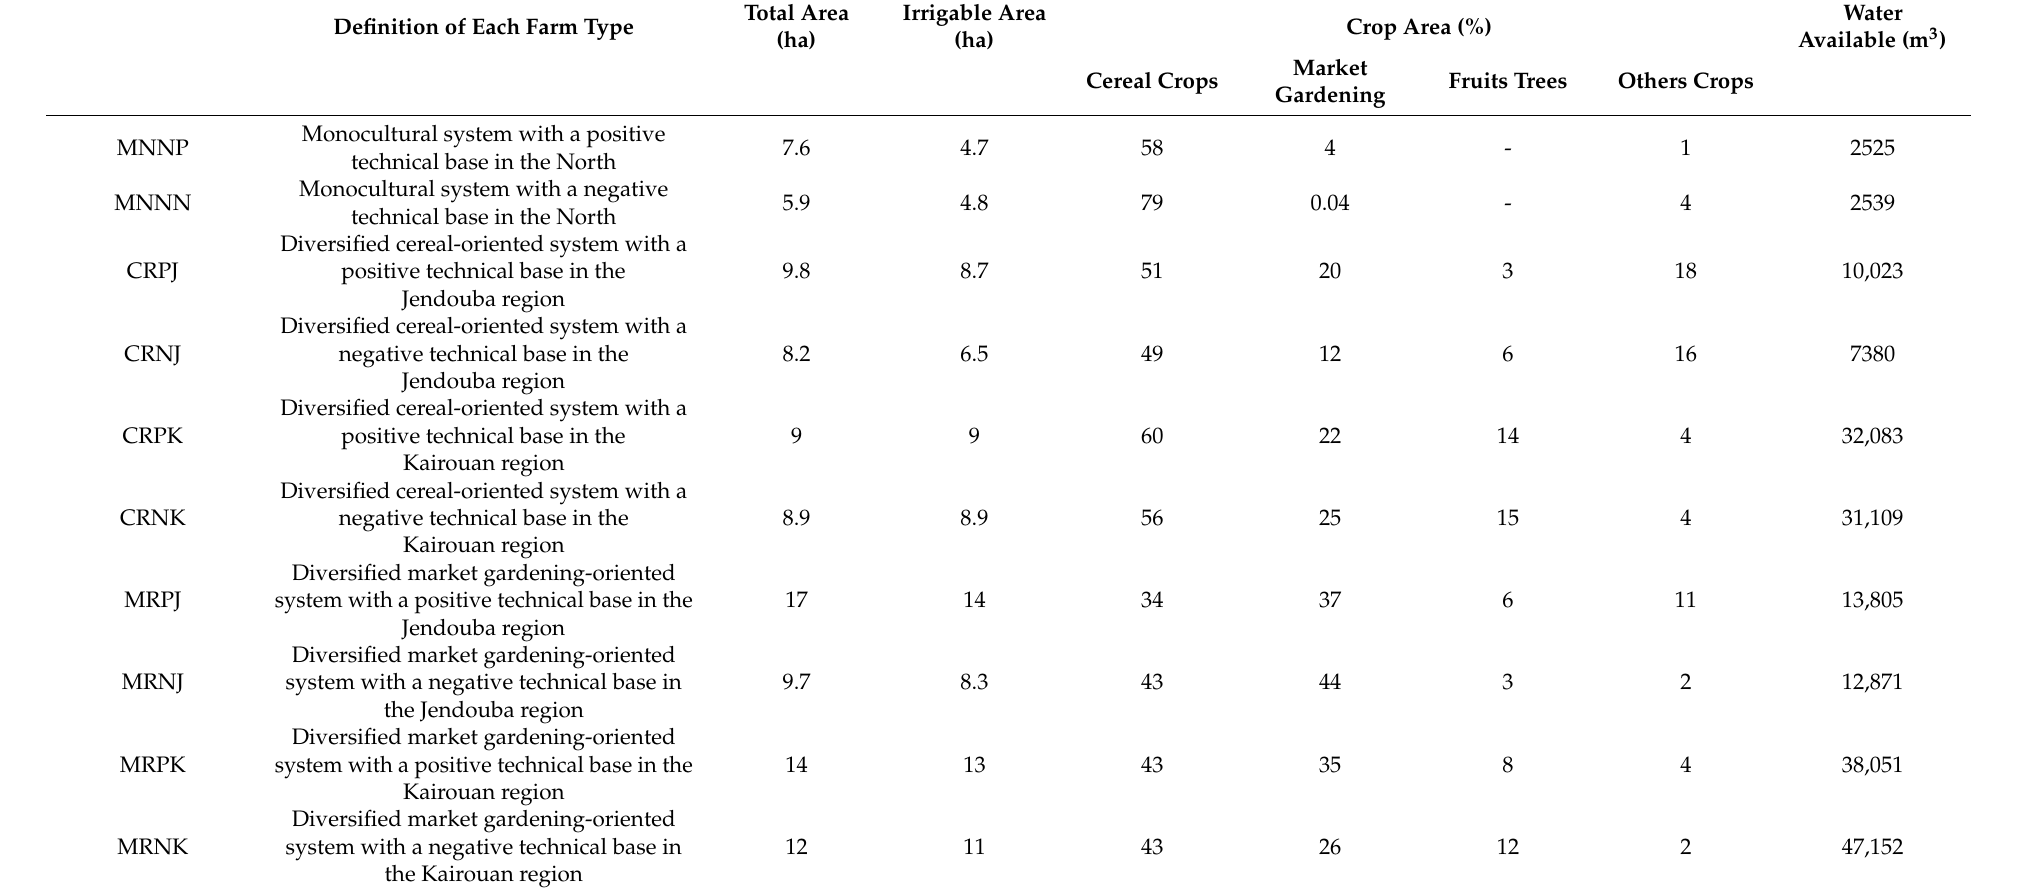
Table 2. Data on the resource endowment of each farm type. Definition of Each Farm Type Crop Area (%)